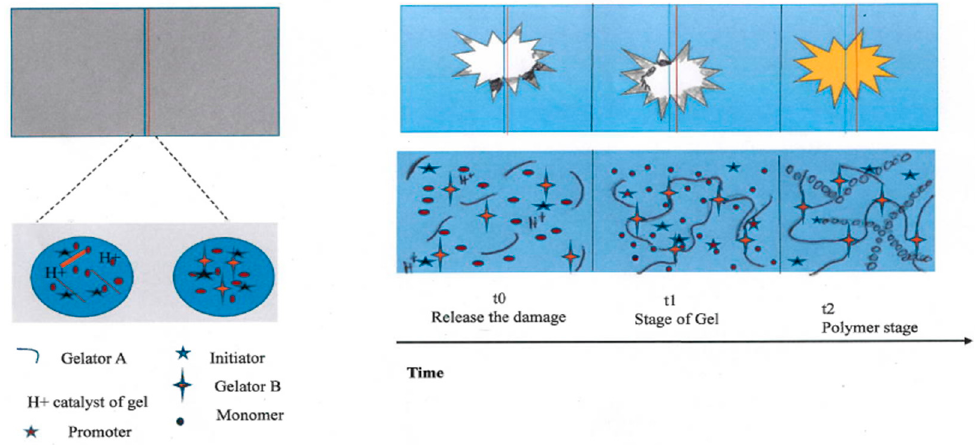
Figure 8. The avascular approach integrates reactive monomer solutions into a vascularized specimen. (Adapted from [62]).